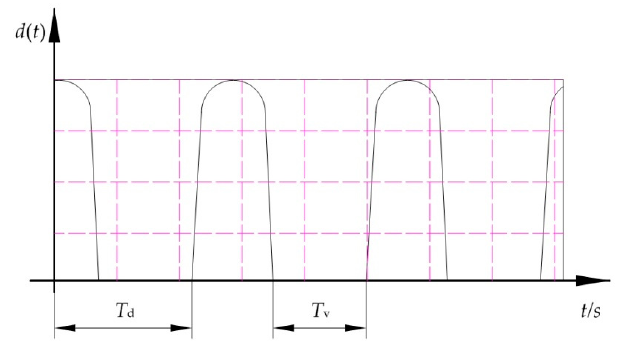
Figure 3. Fault rectangular pulse sequence produced by contact of the rolling elements with the spalling position. spalling